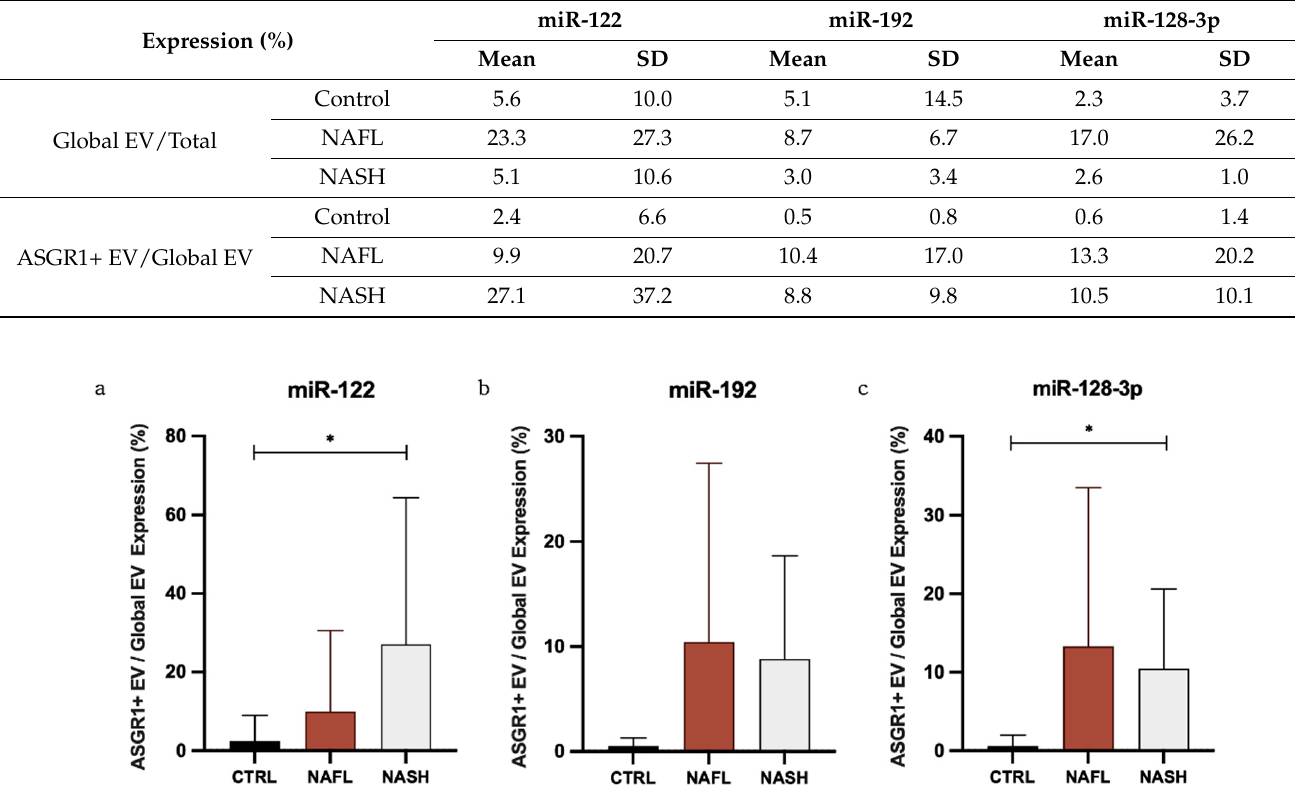
Figure 4. Relative expression of miRNA in liver-specific EVs. Expressions of miR-122 ( a ), miR-192 ( b ), and miR-128-3p ( c ) in asialoglycoprotein receptor 1 positive (ASGR1+) EVs as a percentage of global EVs in NAFL and NASH patients compared with controls. Statistical analysis performed by the Kruskal–Wallis test with Dunn’s for multiple comparisons. * p ≤ 0.05. Error bars represent standard deviation.